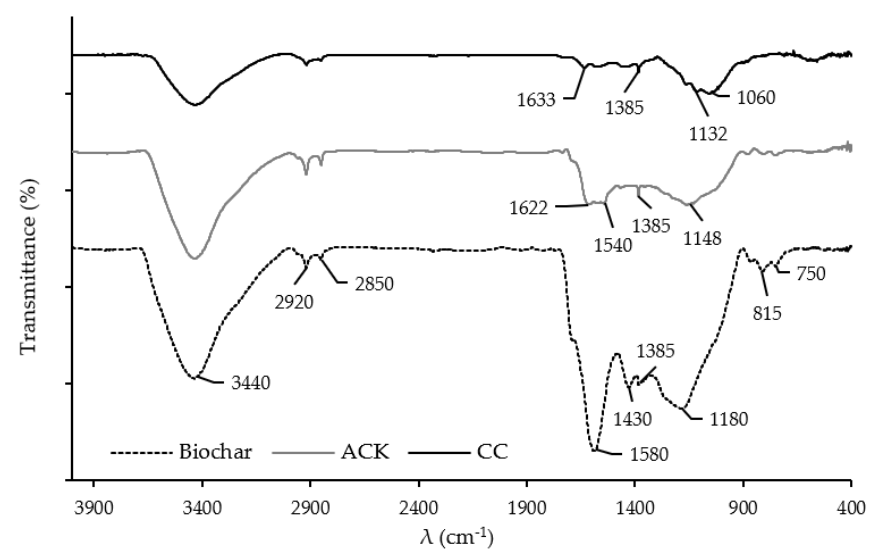
Figure 2. FTIR spectra of char and the ACK and CC porous carbons.